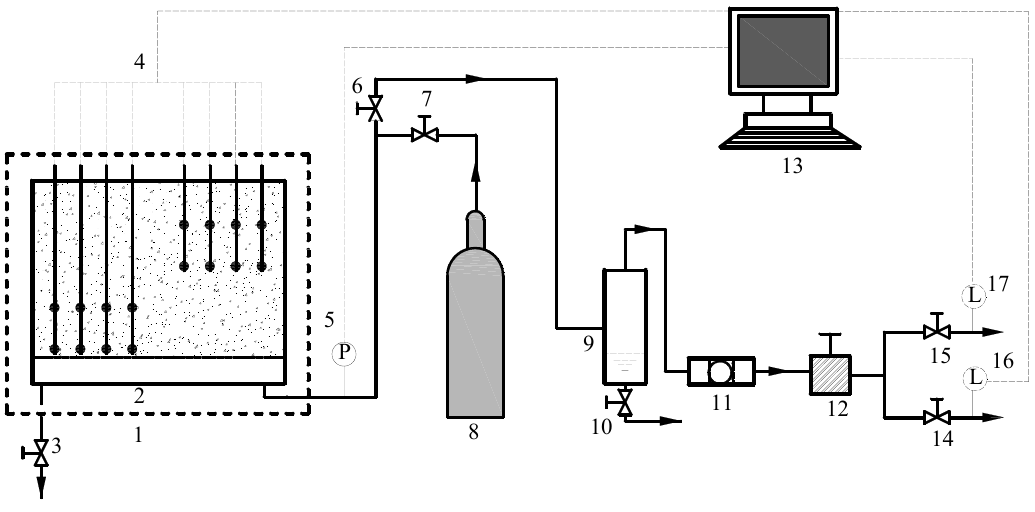
Figure 3. Experimental apparatus for gas production from hydrates by depressurization [61,62]: (1) air bath; (2) reactor; (3) gas discharge valve; (4) thermocouples; (5) pressure transducers; (6) vent valve; (7) gas injection valve; (8) gas cylinder; (9) gas-water separator; (10) drain valve; (11) filter; (12) back-pressure regulator;